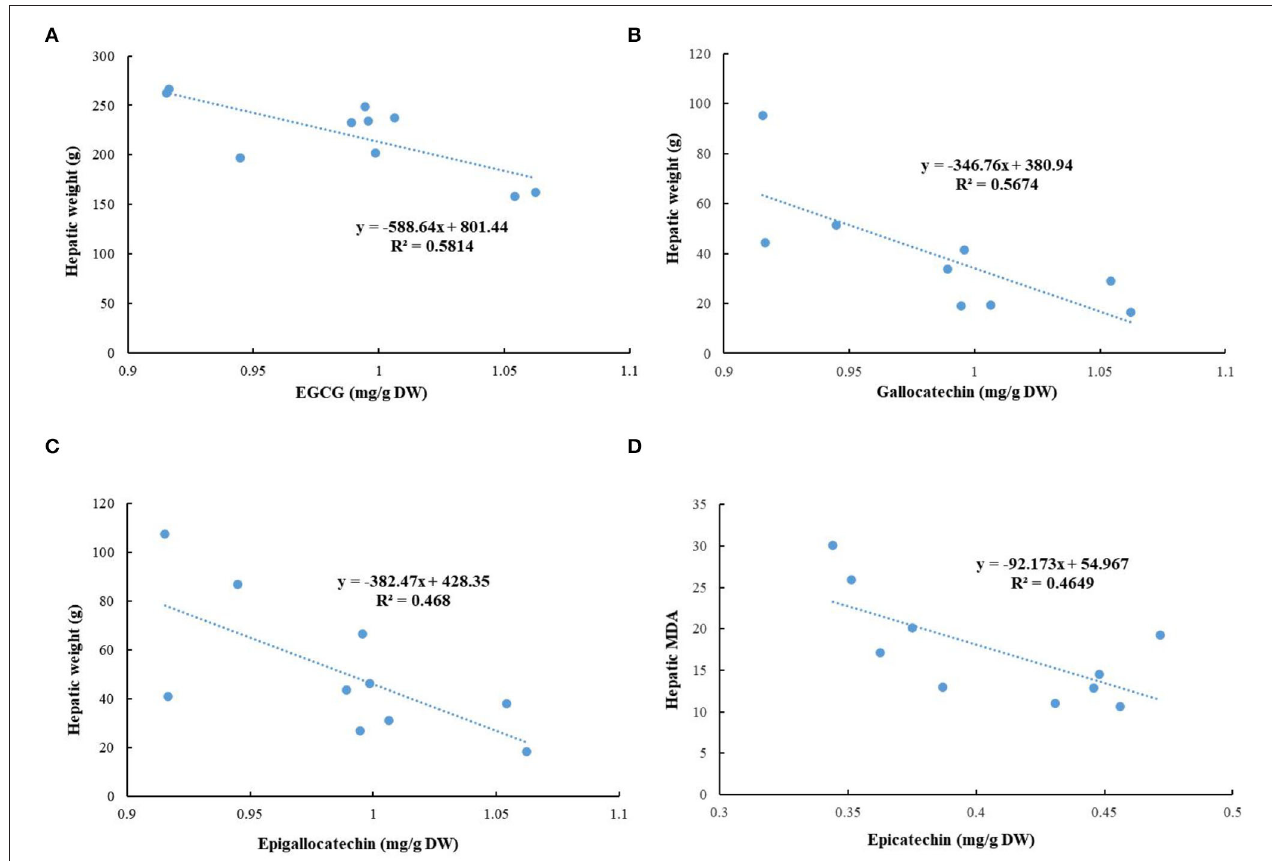
FIGURE 10 | Correlation analysis. (A) Epigallocatechin gallate (EGCG) and hepatic weight; (B) gallocatechin and hepatic weight; (C) epigallocatechin and hepatic weight; and (D) epicatechin and hepatic